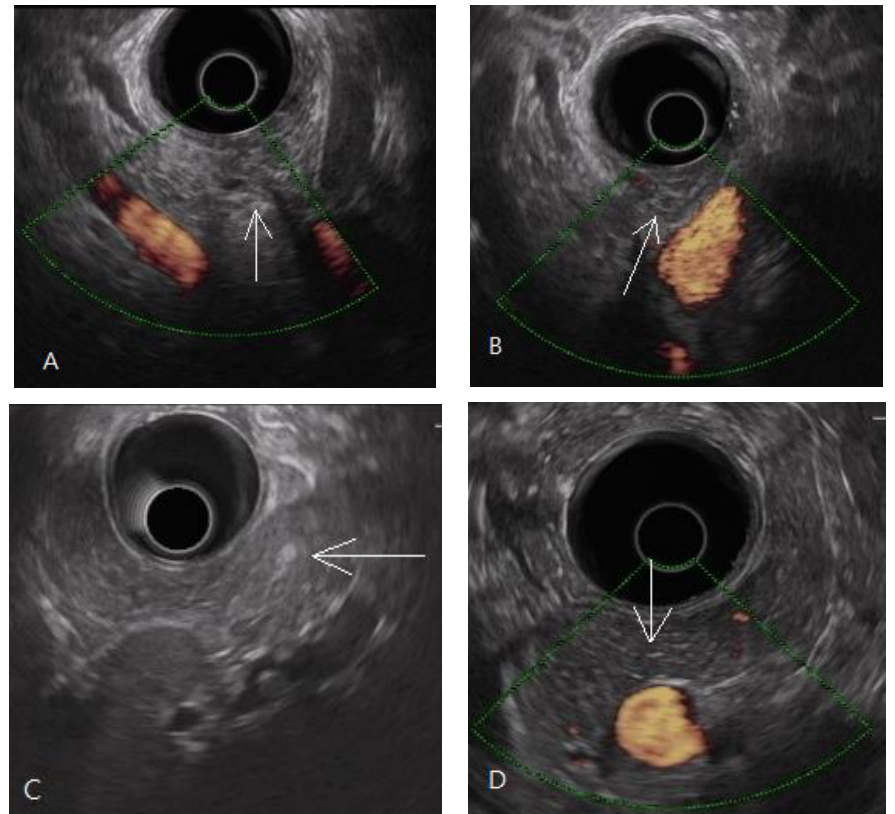
Figure 2. Endoscopic ultrasonography of early chronic pancreatitis. ( A , B ) Pancreatic head lobular- ity (arrow mark) showing heterogeneous parenchyma with hyper/hypo echoic areas mixing, irregular hyperechoic stranding. ( C ) A hyperechoic focus without an acoustic shadow (arrow mark) in the pancreatic tail. ( D ) Hyperechoic stranding in body, neck (arrow mark).